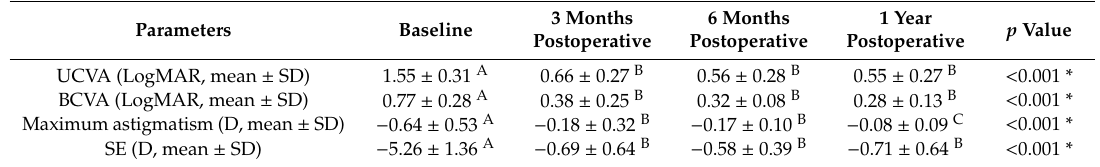
Table 2. The change in visual acuity and refractive status in the primary group after the topography-guided laser in situ keratomileusis.